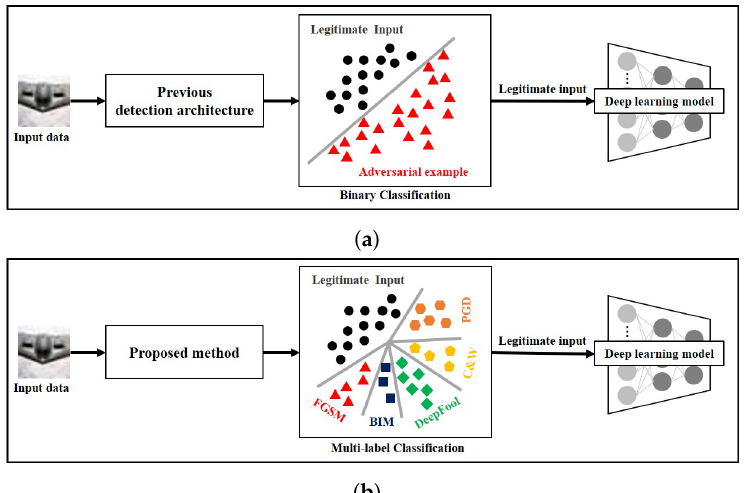
Figure 1. Difference between the previous defense methods using adversarial example detection architecture and the proposed method. ( a ) Previous defense methods using adversarial example detection architecture. ( b ) Proposed